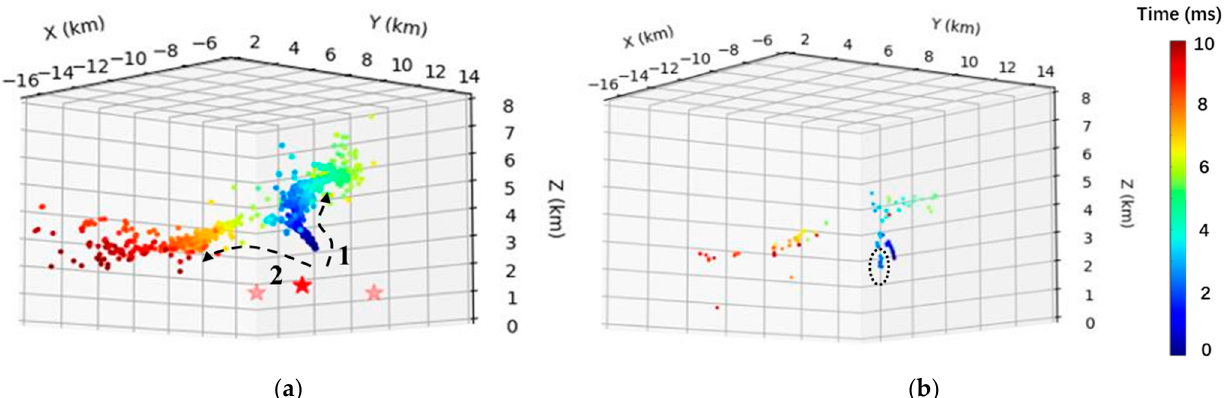
Figure 9. A comparison between 3D mapping results of InLMA and DALMA for the initial 10 ms of the flash. ( a ) 3D mapping of InLMA with locations of three stations of InLMA. ( b ) 3D location result from DALMA.